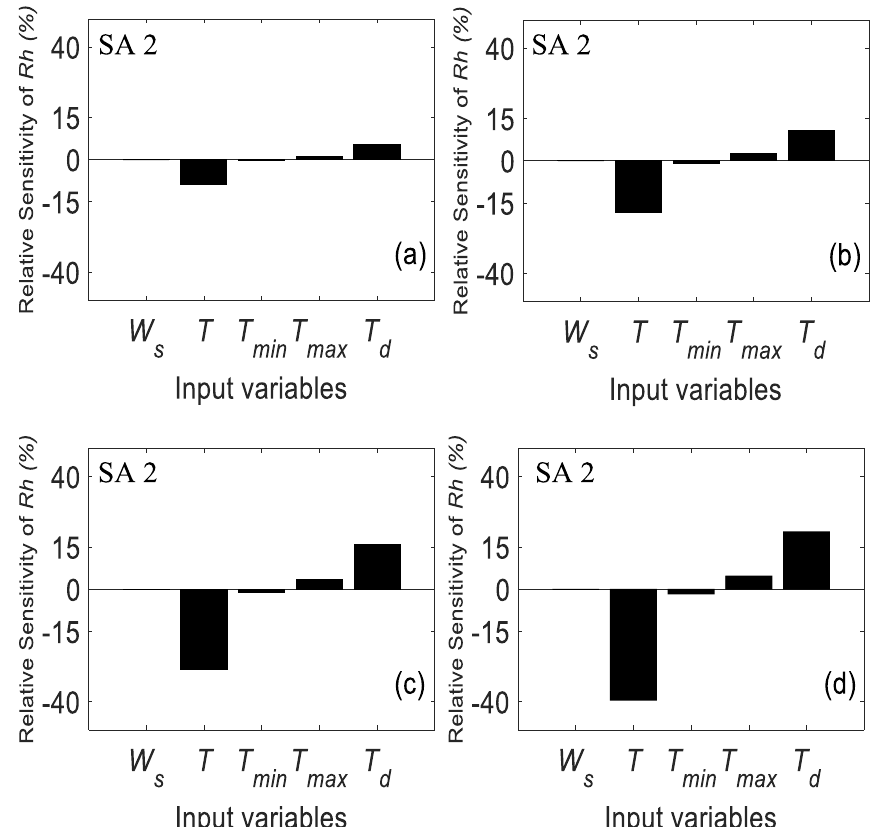
Fig. 14 Sensitivity analysis chart for configuration scenario